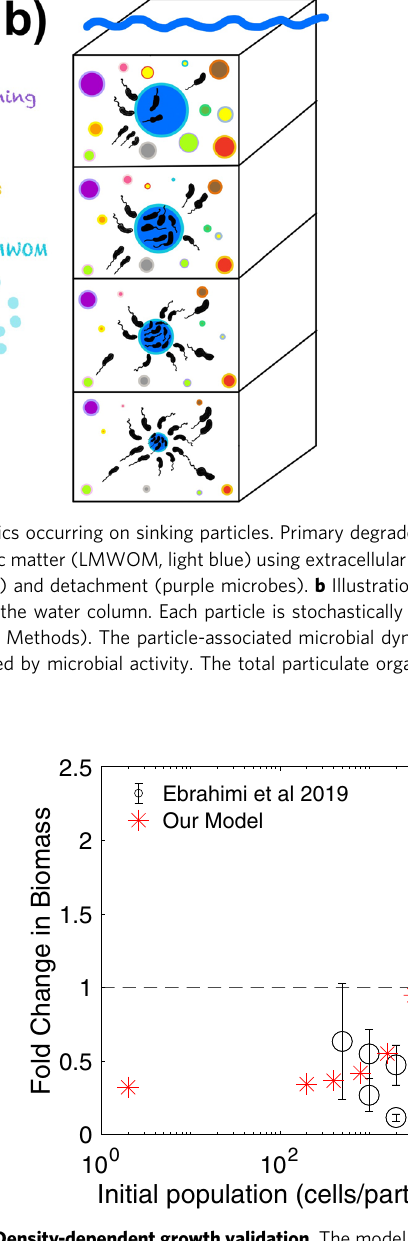
Fig. 2 Density-dependent growth validation. The model captures observed density-dependent growth of particle-associated communities. Fold change in microbial population biomass after 10 hours of growth is shown for the model simulations (red asterisks) and experimental data (open circles, Ebrahimi et al. (2019)). Error bars on the open circles represent standard error of measurement from at least three measurements of particle colonization density from Ebrahimi et al.